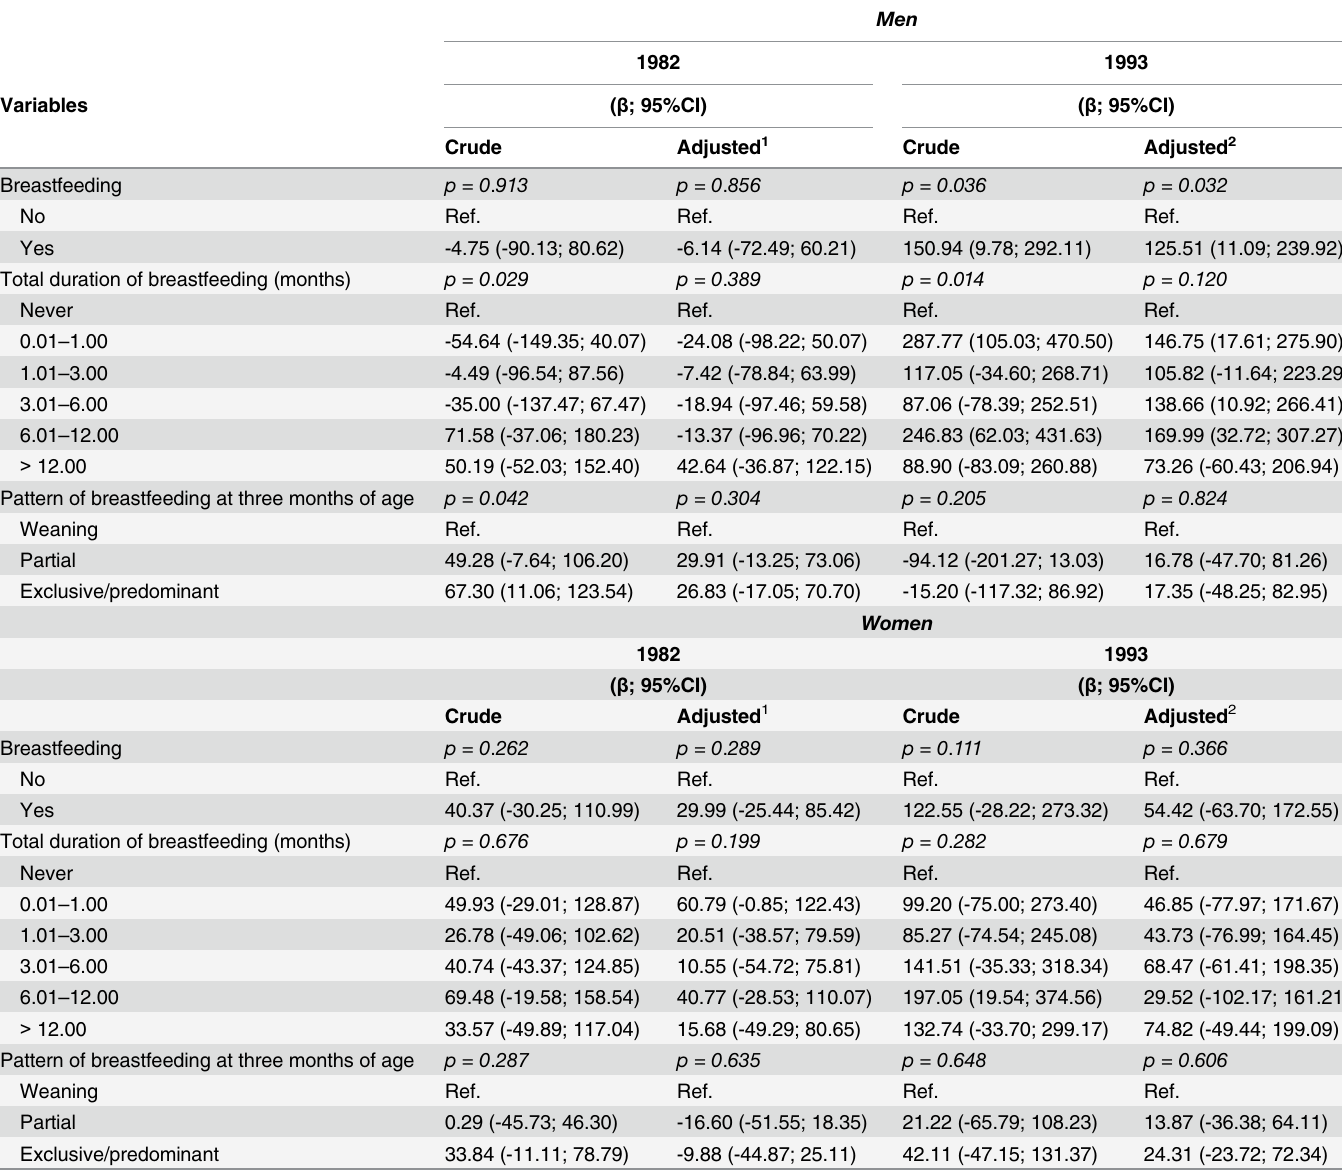
Table 3. Crude and adjusted coefficients of the association between breastfeeding variables and whole body bone mineral content (BMC) at 18 and 30 years for men and women. The 1982 and 1993 Pelotas Birth Cohorts.